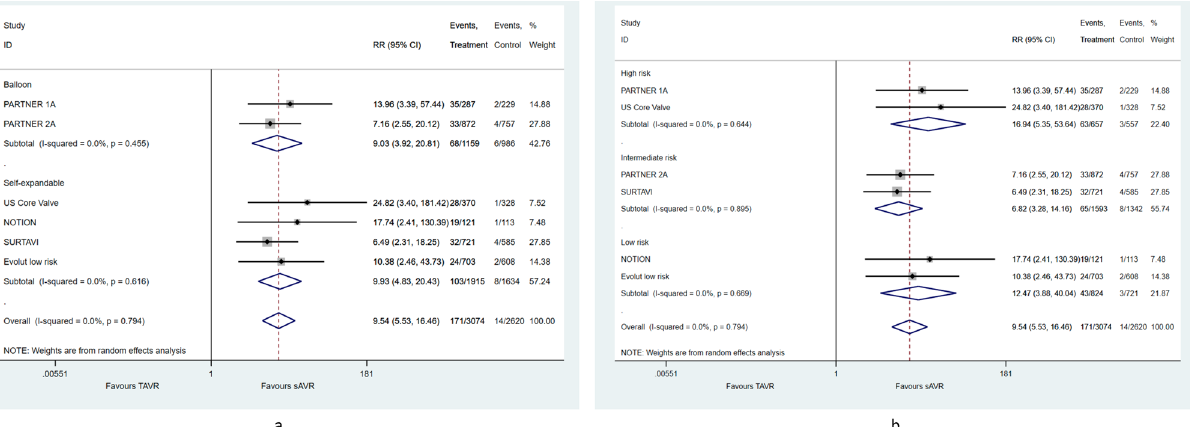
Figure 5. Pooled relative risk of post-procedural moderate/severe paravalvular leak, according to ( a ) transcatheter heart valve system and ( b ) surgical risk on